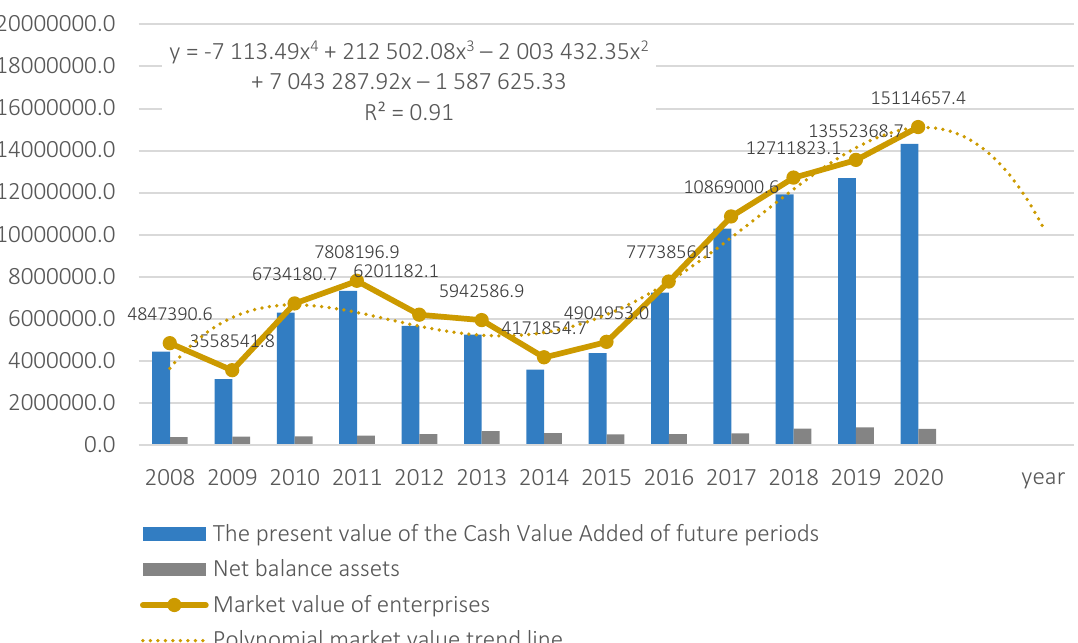
Figure 2. Dynamics of the aggregate market value of Ukrainian industrial enterprises,